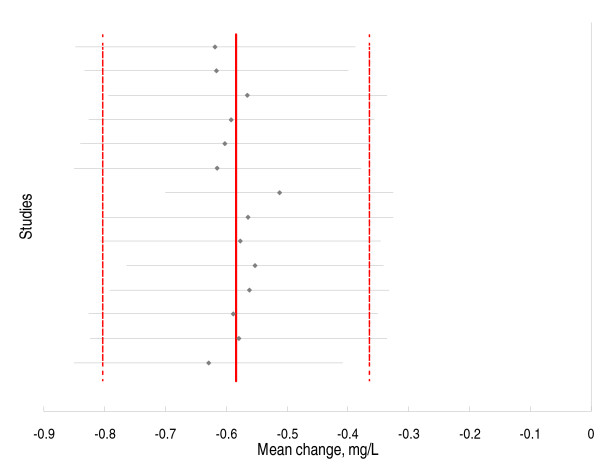
Effect of excluding one study at time on the overall estimated effect of fenofibrate on C-reactive protein concentrations. The solid line indicates the pooled estimate while the dashed lines indicate the 95% confidence intervals. The studies were excluded from the analysis in the order they appear in the Forest plot (Figure 2) i.e., the study by Kim et al was excluded first and the study by Hogue et al was excluded last.